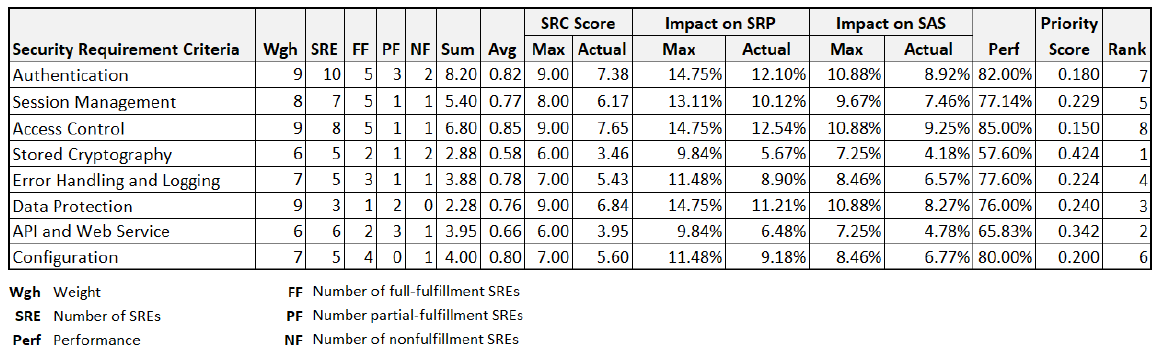
Figure 4. Security assurance scoreboard—security requirement metrics.